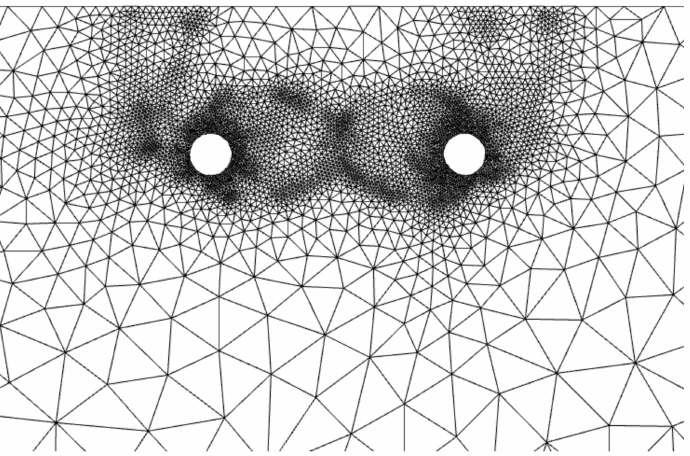
Figure 2. Detailed mesh arrangement in